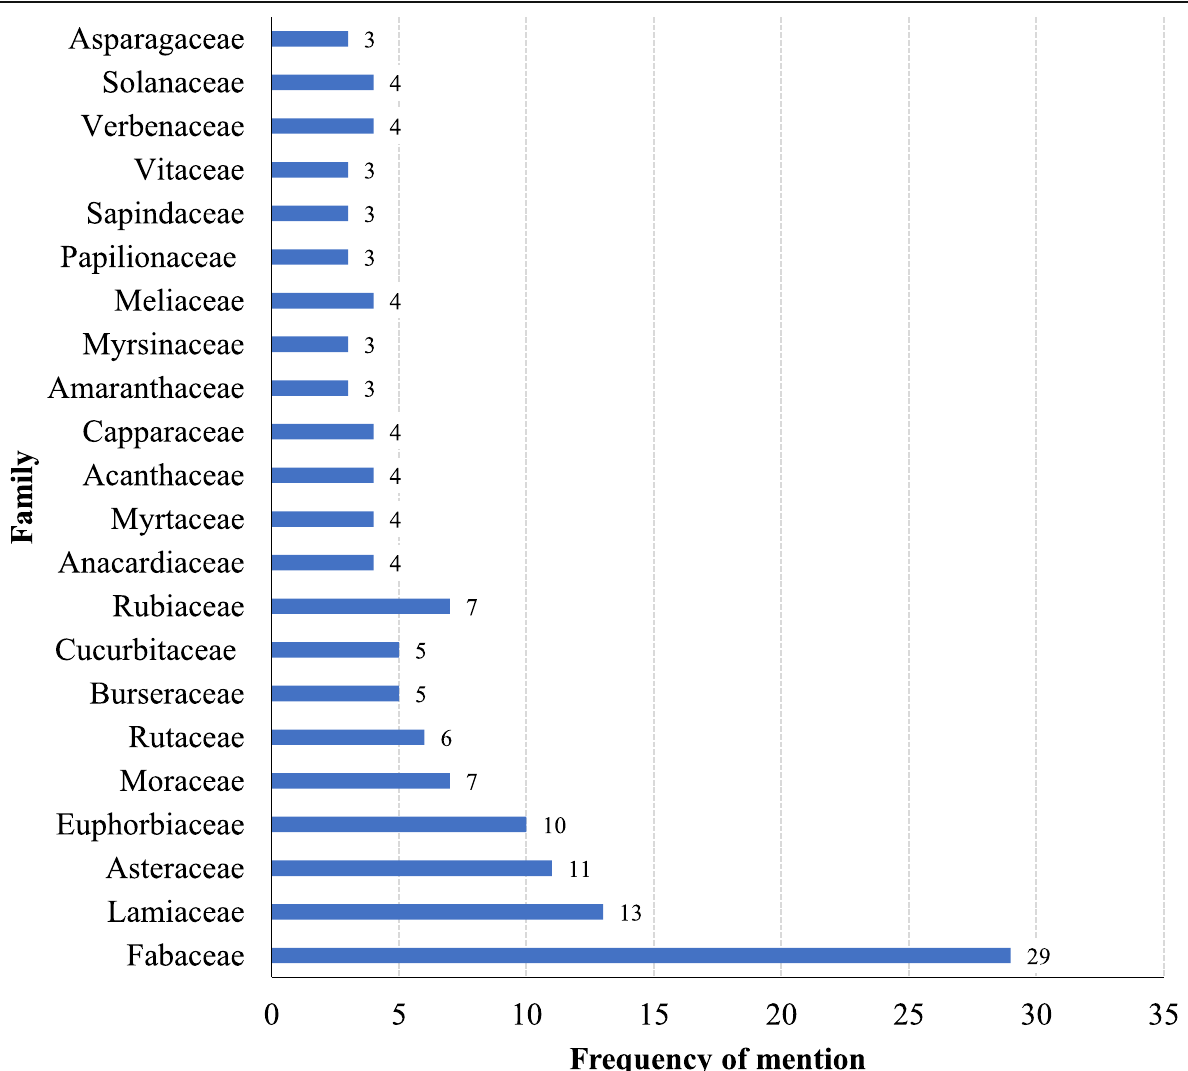
Fig. 1 Major botanical families from which TB remedies are obtained in East